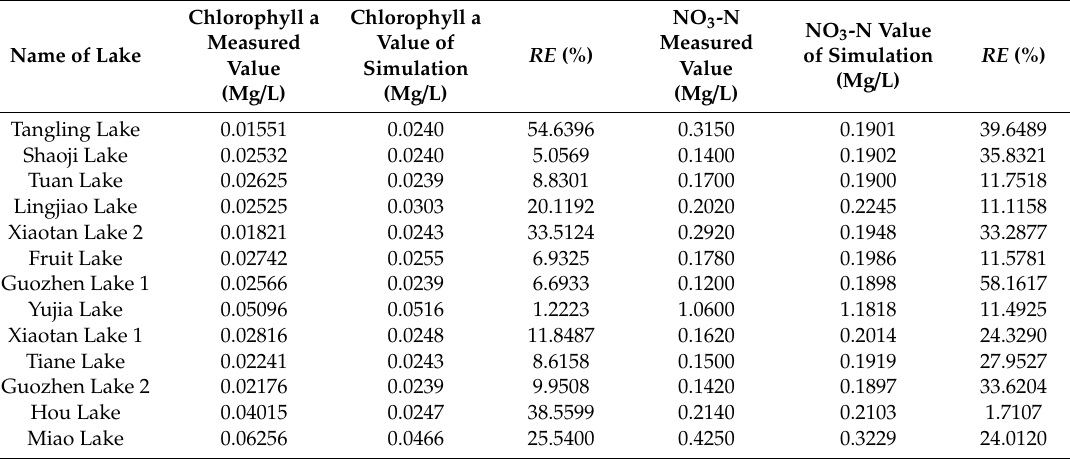
Table 7. The error analysis after optimization based on